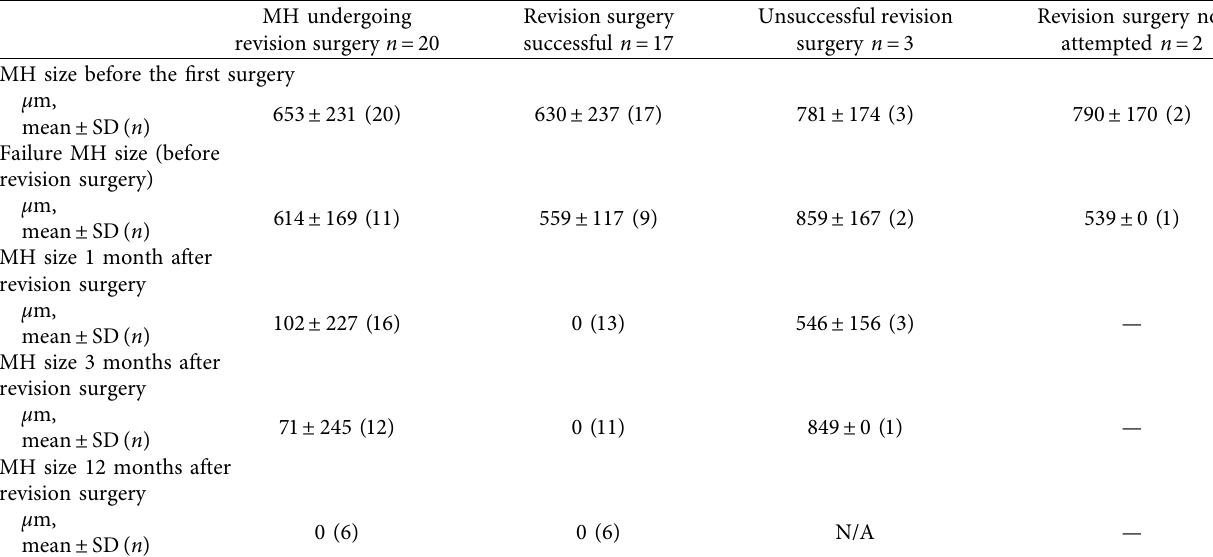
Table 4: Evolution of MH size.